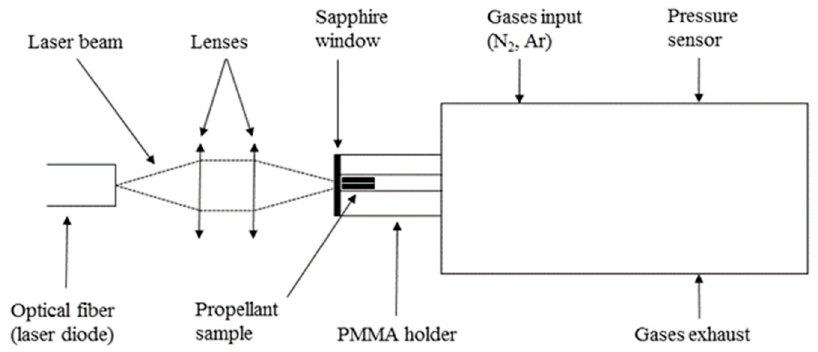
Figure 17. Schematic overview of the laser ignition setup.